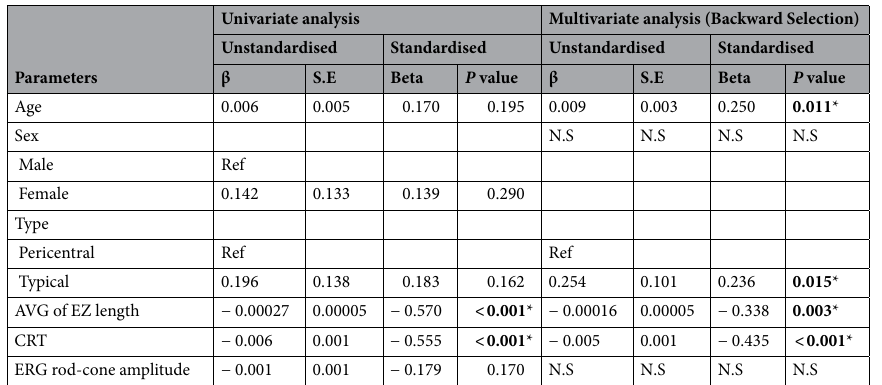
Table 3. Univariate and multivariate analyses between logarithm of the minimum angle of resolution (logMAR) visual acquity (VA) and parameters. * p < 0.05. AVG of EZ length average length of intact